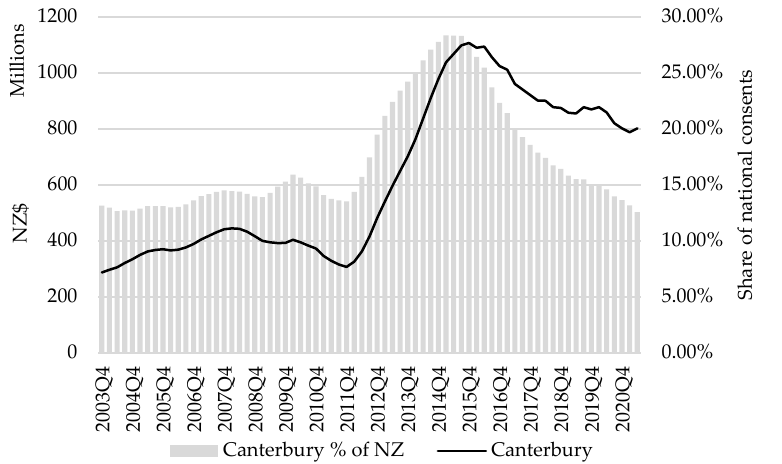
Figure 2. Building consent value (NZD), 12-month moving average, quarterly. Source : (StatsNZ 2021a) and author’s calculations.